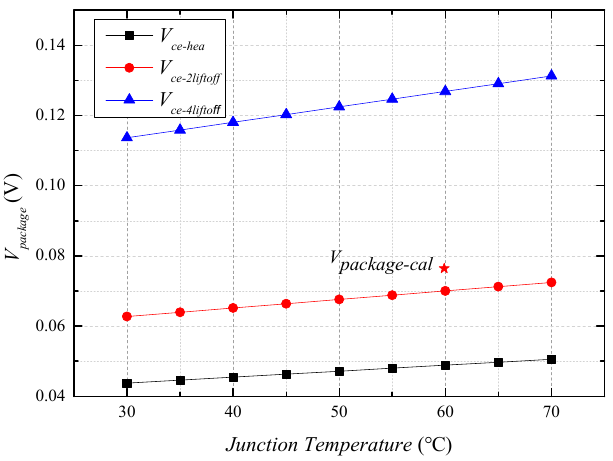
Figure 12. The package voltage at different junction temperatures ( I c = 20 A).